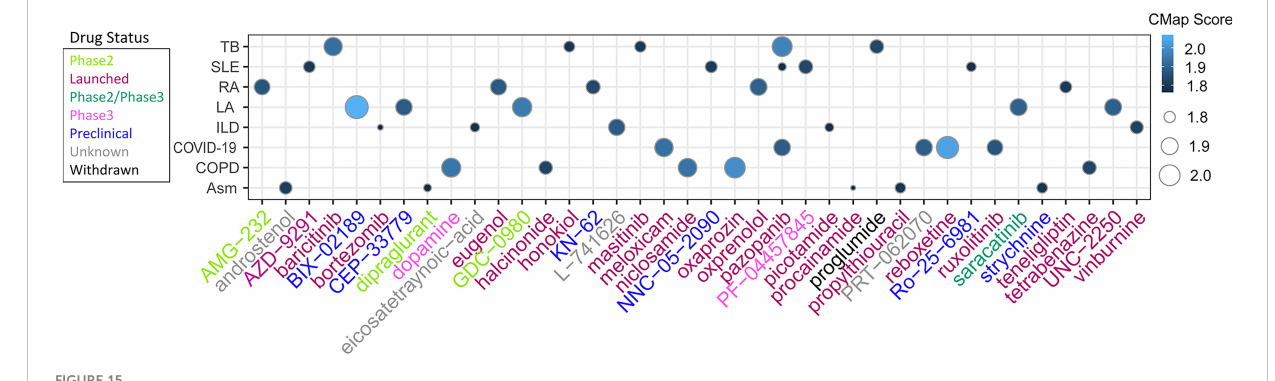
FIGURE 15 Heatmap showing CMap scores of PCD-related DEGs to drugs. The size of dots corresponds to absolute values of the CMap